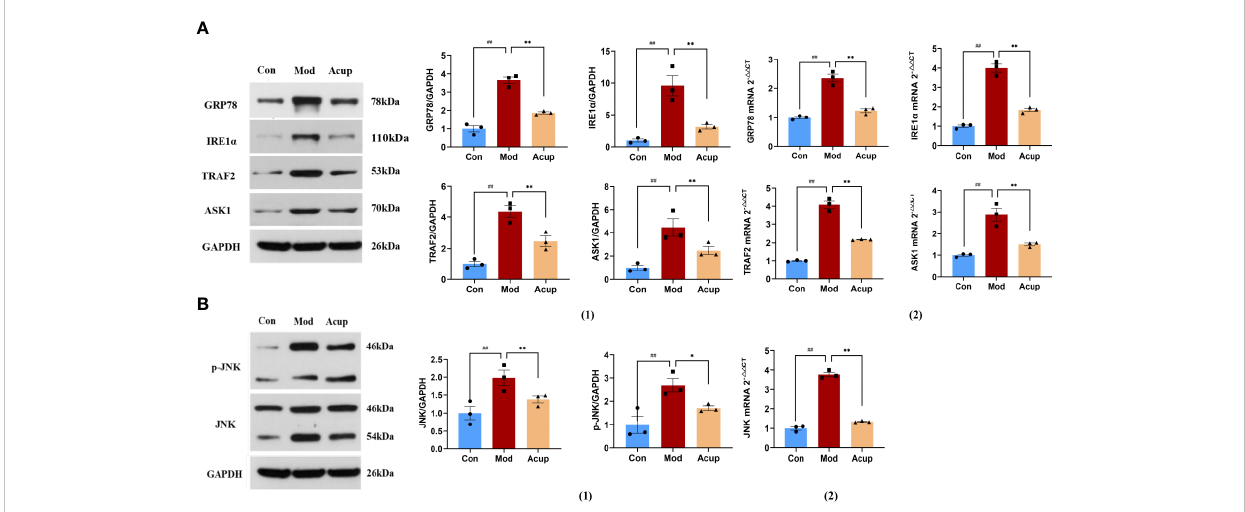
FIGURE 5 Electroacupuncture regulates the expression of key proteins in the ERS. (A) (1) Western blotting and quantitative analysis of GRP78, IRE1 a , TRAF2 andASK1 expression in the hippocampus of mice in three groups; (2) RT-PCR analysis of GRP78, IRE1 a , TRAF2 and ASK1 mRNA expression in the hippocampus of mice in three groups. (B) (1) Western blotting and quantitative analysis of JNK and p-JNK expression in the hippocampus of mice in three groups; (2) RT-PCR analysis of JNK mRNA expression in the hippocampus of mice in three groups. Data are expressed as means ± SEM. Mod vs Con, ## p < 0.01; Acup vs Mod, * p < 0.05, ** p <